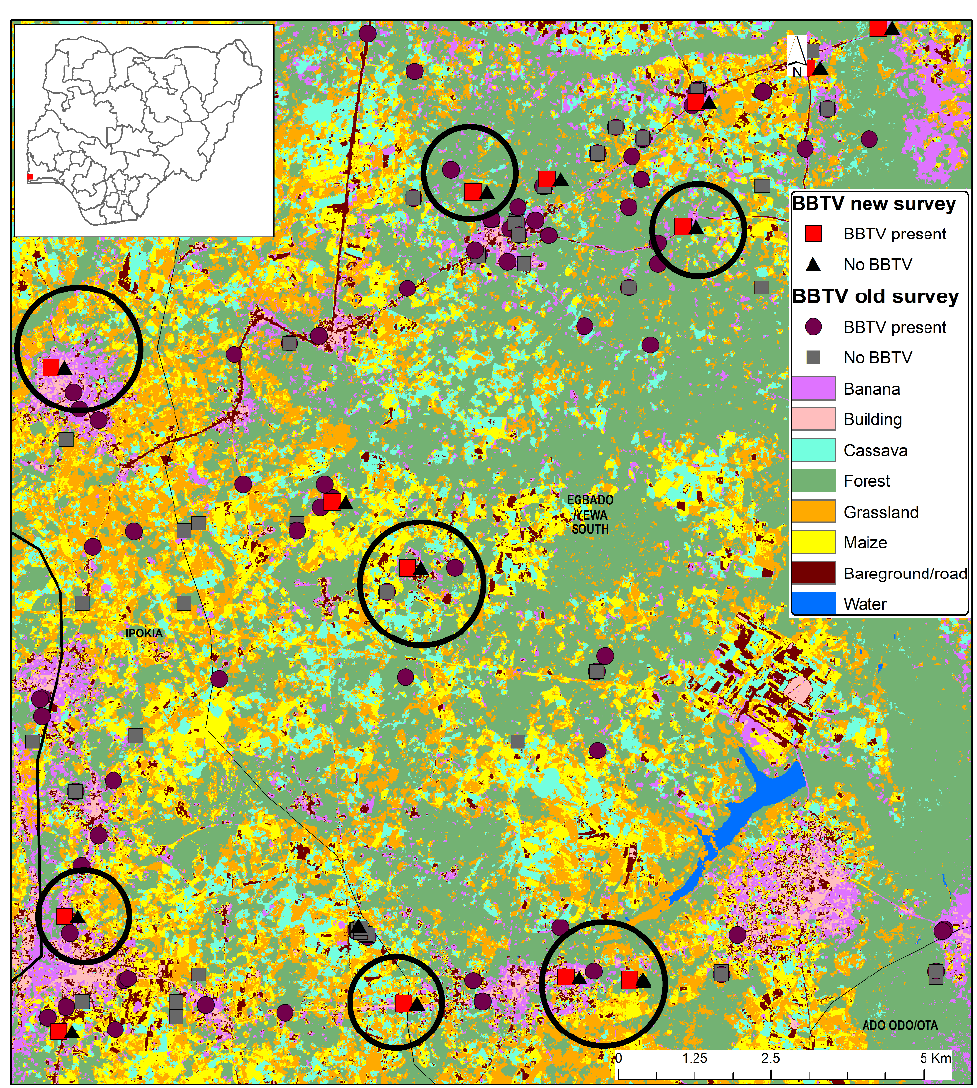
Figure 6. Prediction of banana and other land cover types on the sites of BBTV occurrence in the Idologun region in Nigeria. New survey areas for BBTV surveillance identified using the banana mapping framework developed in this study are shown in black circles.